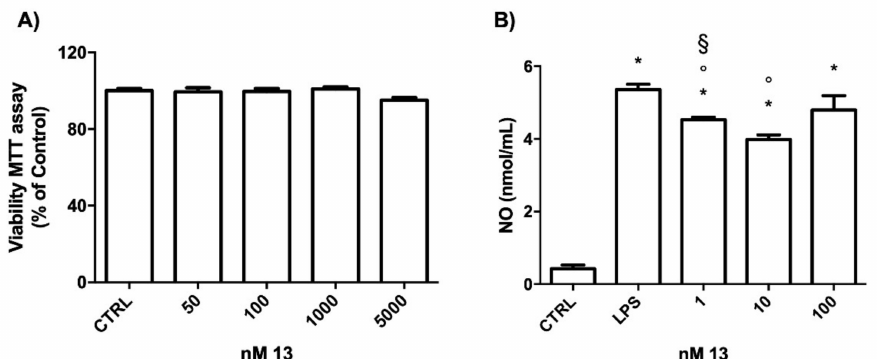
Figure 4. Effect of 13 on cell viability and NO production in BV-2 cells. ( A ) Cells were treated with 50–5000 nM of 13 for 24h, and MTT assay was used to measure cell viability. ( B ) Cells were treated with 10 nM of 13 before activation with 100 ng/mL LPS for 24 h and NO release was measured by the Griess assay. Each bar represents means ± SEM of at least three independent experiments. Data were analyzed by one-way ANOVA followed by Bonferroni’s test. * p < 0.05 vs. CTRL; ◦ p < 0.05 vs. LPS; § p < 0.05 vs. 10